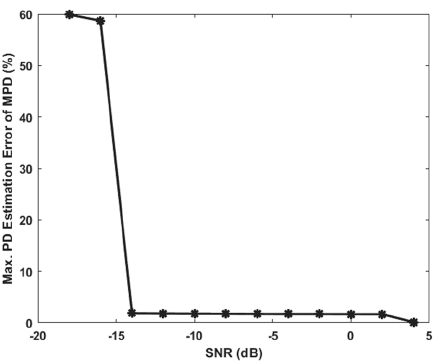
Figure 10. Maximum PD estimation error versus SNR for the MPD algorithm.